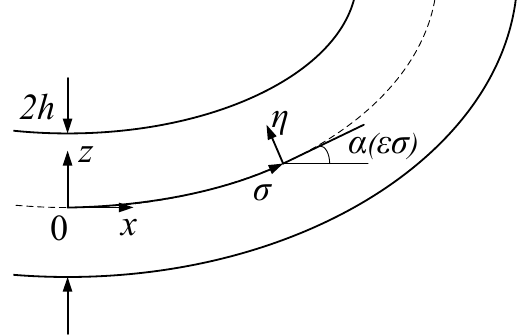
Figure 1. The homogeneous and isotropic linearly elastic curved plate.